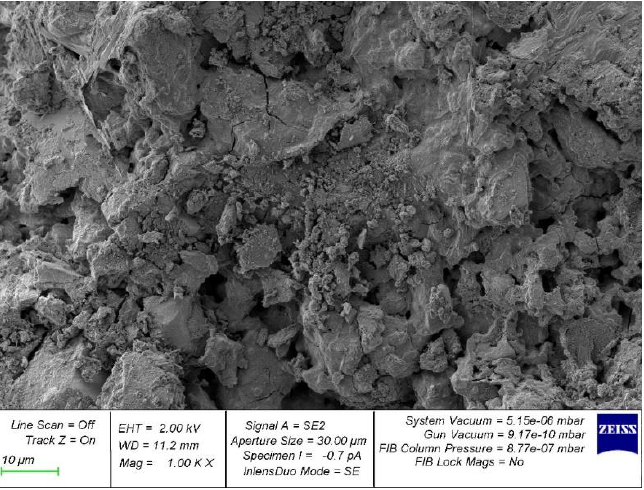
Figure 9. Sample with partial replacement of cement with eggshell powder at 5%.